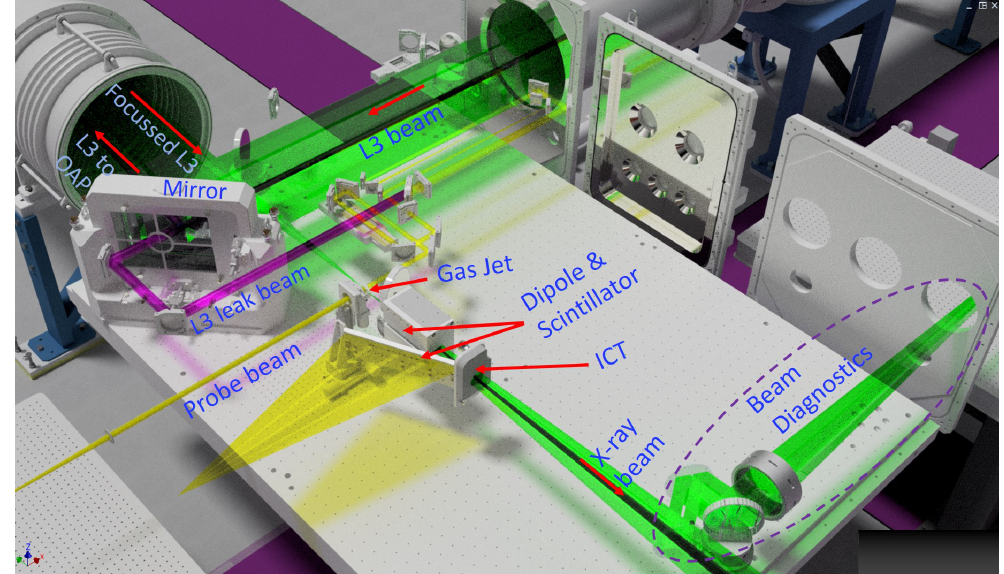
Figure 6. Detailed view of the Gammatron beamline operating in the Betatron scheme and the associated diagnostics inside the interaction